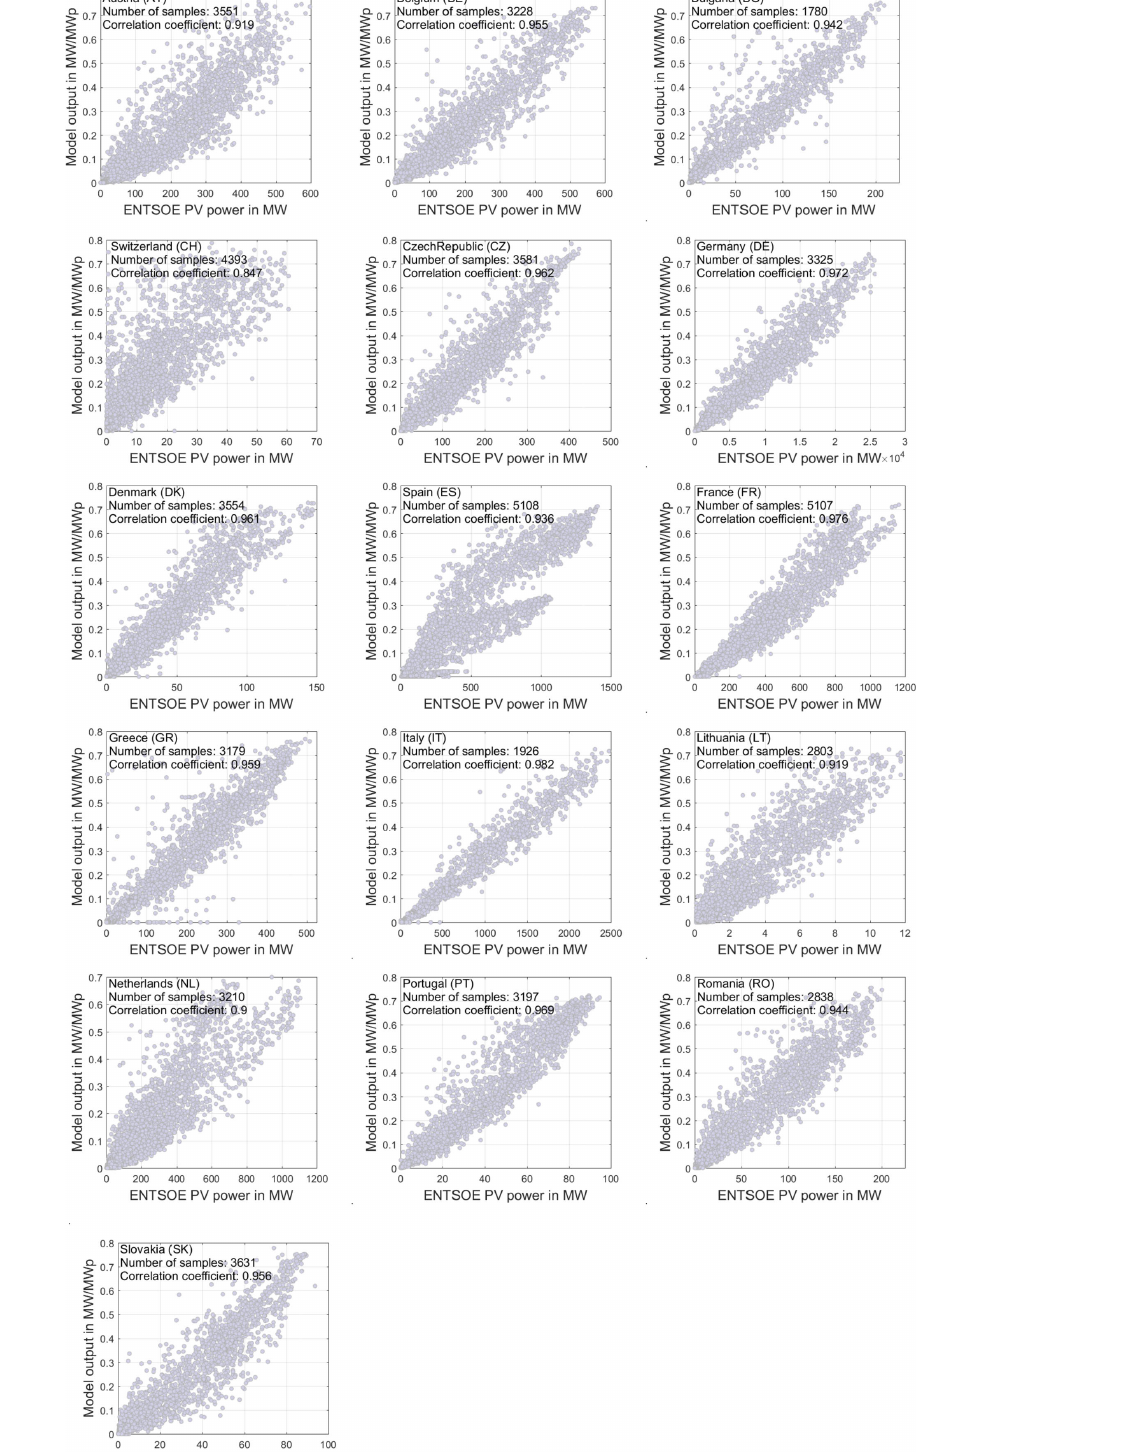
Figure 10. Scatter plots of three-hourly ENTSO-E solar generation data against the corresponding model output for 16 European countries for the year 2016. The modelled PV generation has been calculated with ERA-interim data assuming a spatially constant installed